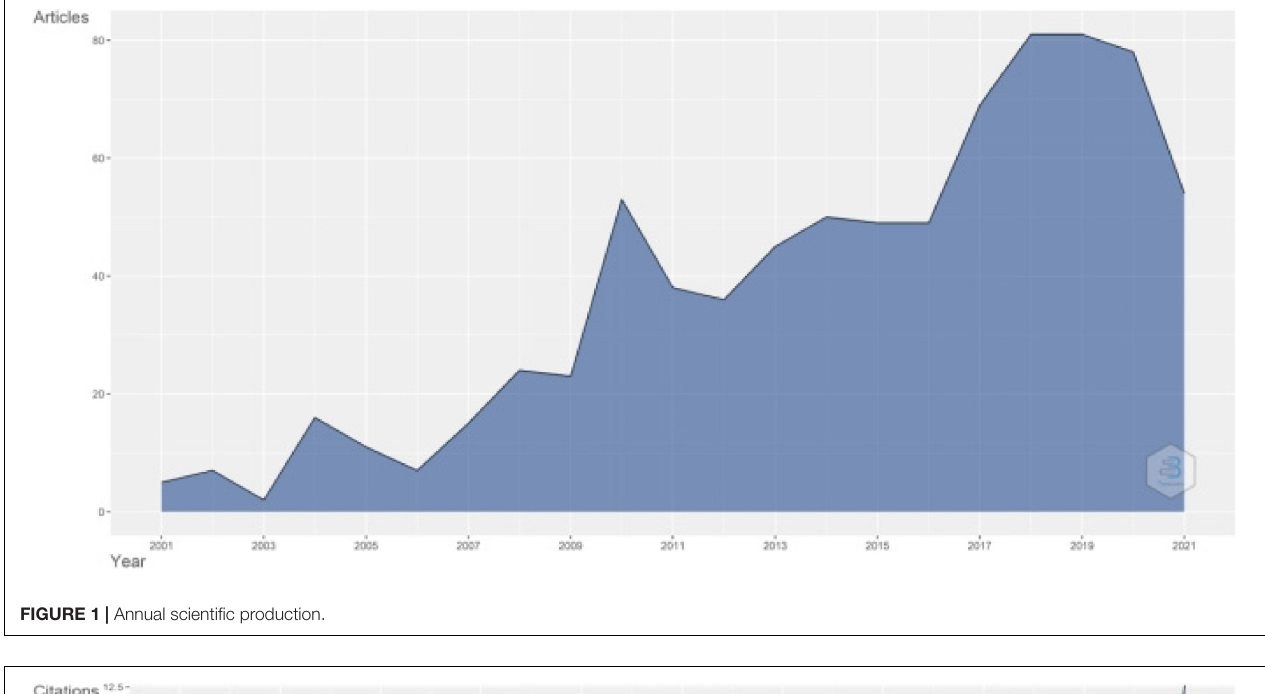
FIGURE 1 | Annual scientific production.